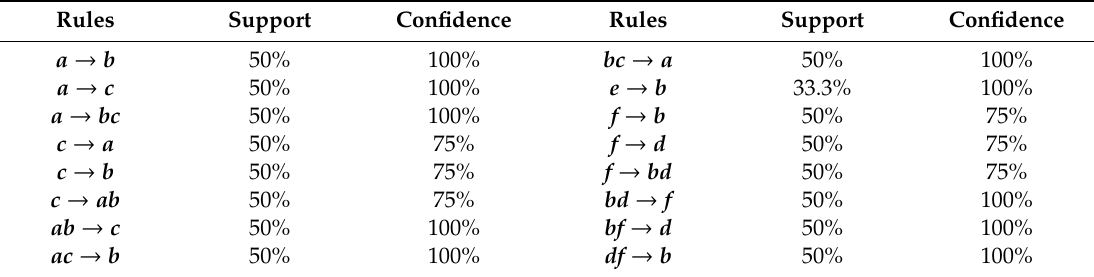
Table 2. Spatial association rules from frequent closed